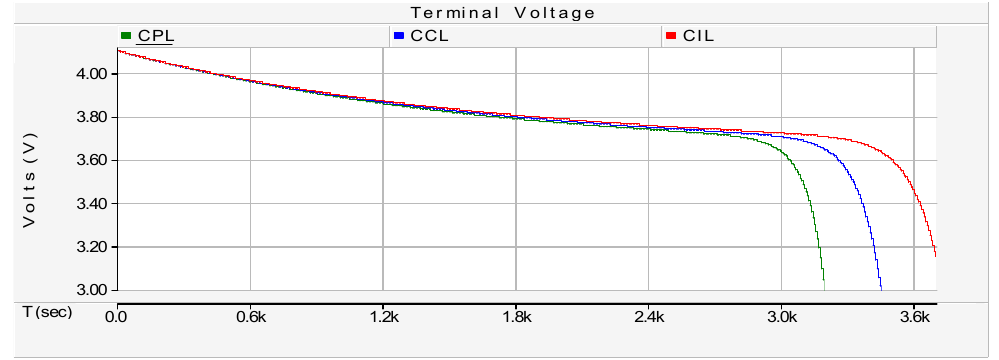
Figure 13. Decreasing pattern of the terminal voltage with the decrease in SOC (left to right).